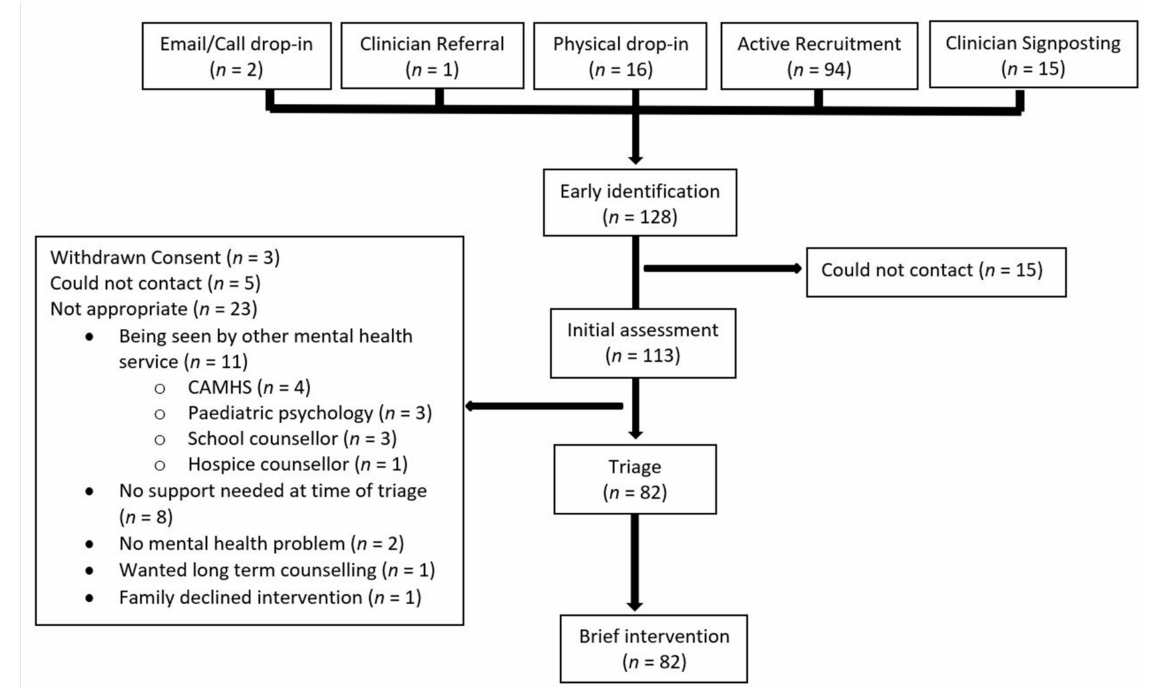
Figure 2. Flowchart showing the flow of participants through the various